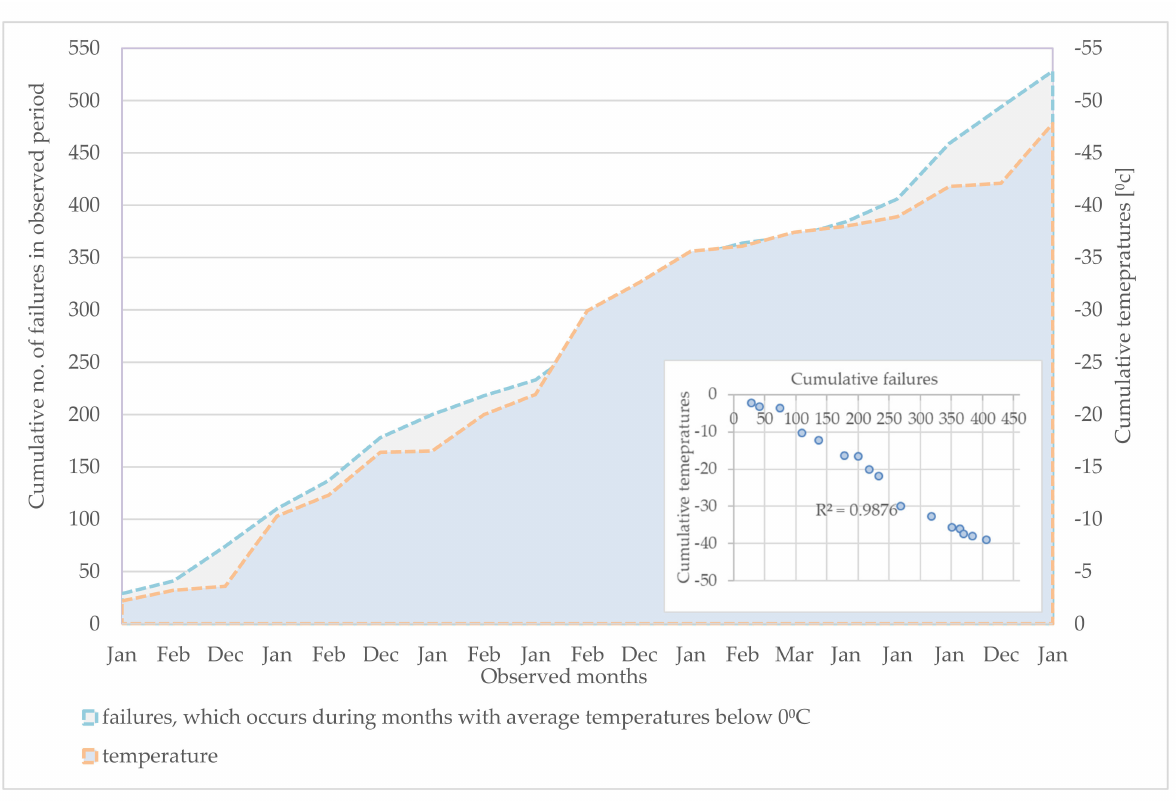
Figure 3. Cumulative failures and temperatures below 0 ◦